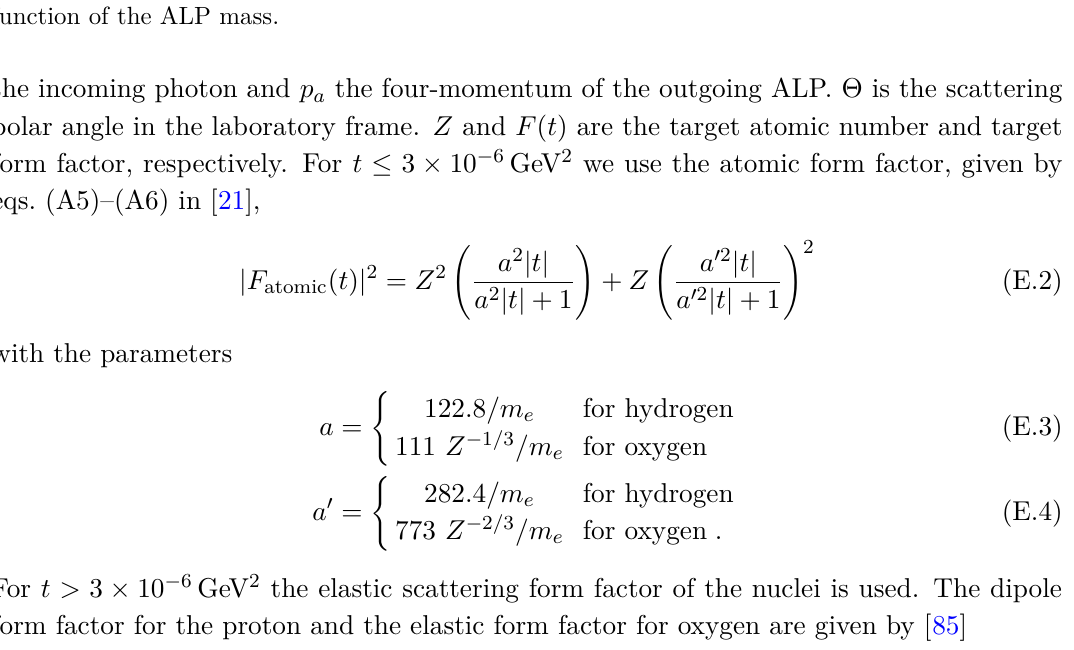
Figure 9 . Branching fractions of the ALP into photons, leptons and hadrons as indicated, as a function of the ALP